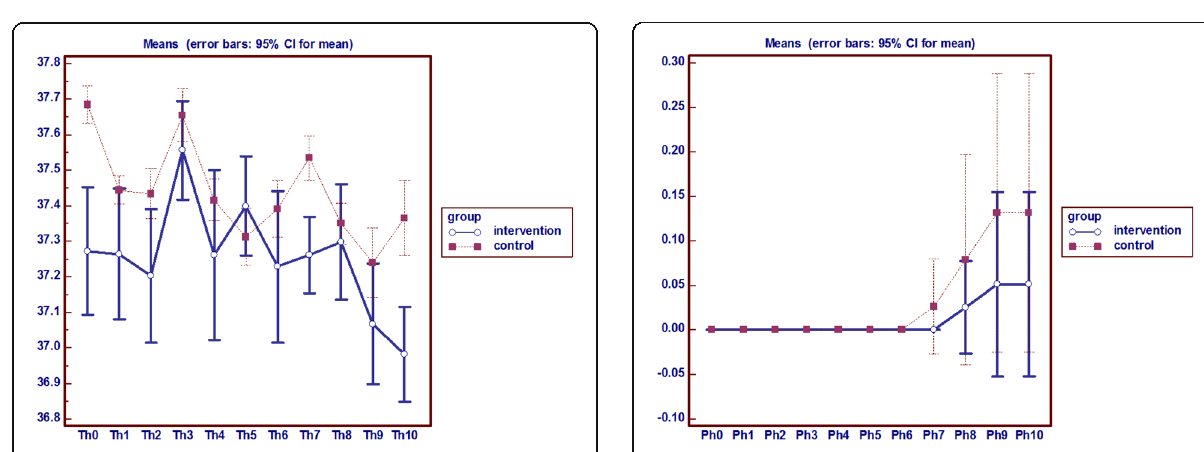
Fig. 3 Analysis of variance with repeated measures on the hip (trochanter)